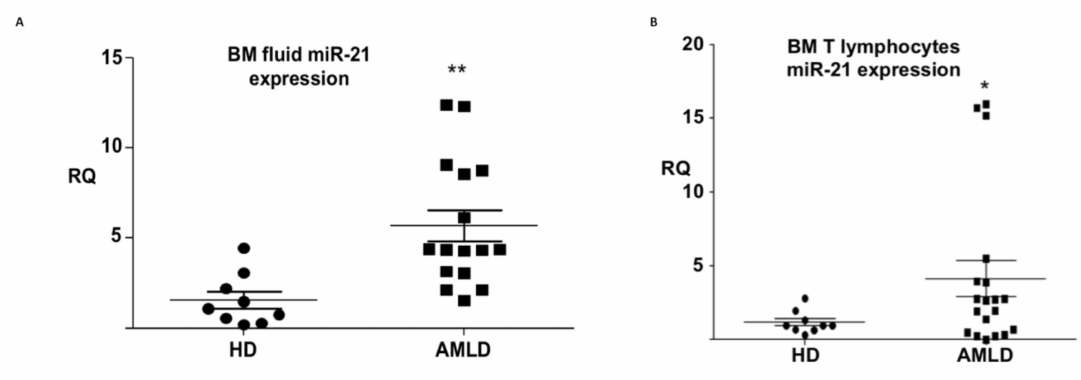
Figure 3. Relative expression level of miR-21 in bone marrow. ( A ) Bone marrow-circulating miR-21 expression in AML patients ( n = 16) compared to HDs ( n = 9). ( B ) MiR-21 is upregulated in AML patient T lymphocytes ( n = 19) compared to HD lymphocytes ( n = 9). Data obtained by quantitative RT-PCR amplification of miR-21 are plotted. All data were collected and statistically analyzed using Student’s t -test. Values are presented as the means of at least three independent experiments. The level of statistical significance was set at p < 0.01 (**) for BM-circulating AMLD vs HD and p ≤ 0.05 (*) for BM CD3 AML vs